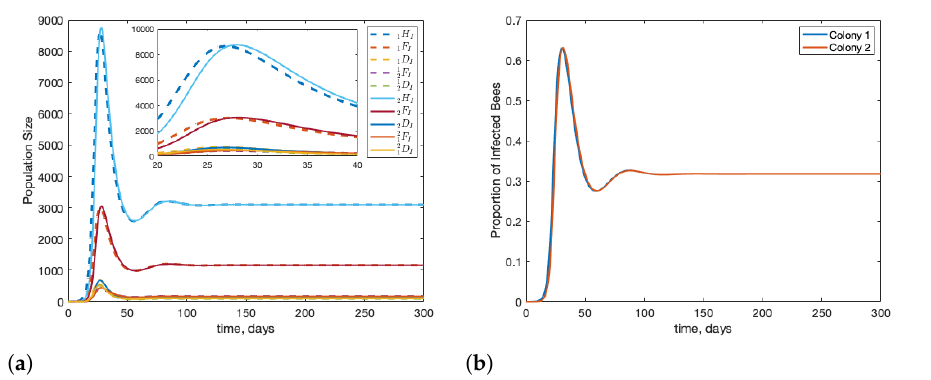
Figure 3. Beginning from equilibrium, we introduce one infected forager into colony 1 ( 1 F I ( 0 ) = 1). We see that infection can travel quickly between two colonies with little delay. Note that the infection in the second colony peaks slightly higher than in the source colony. Panel ( a ) shows the population of infected bees over time and panel ( b ) shows the proportion of bees in each colony that are infected over